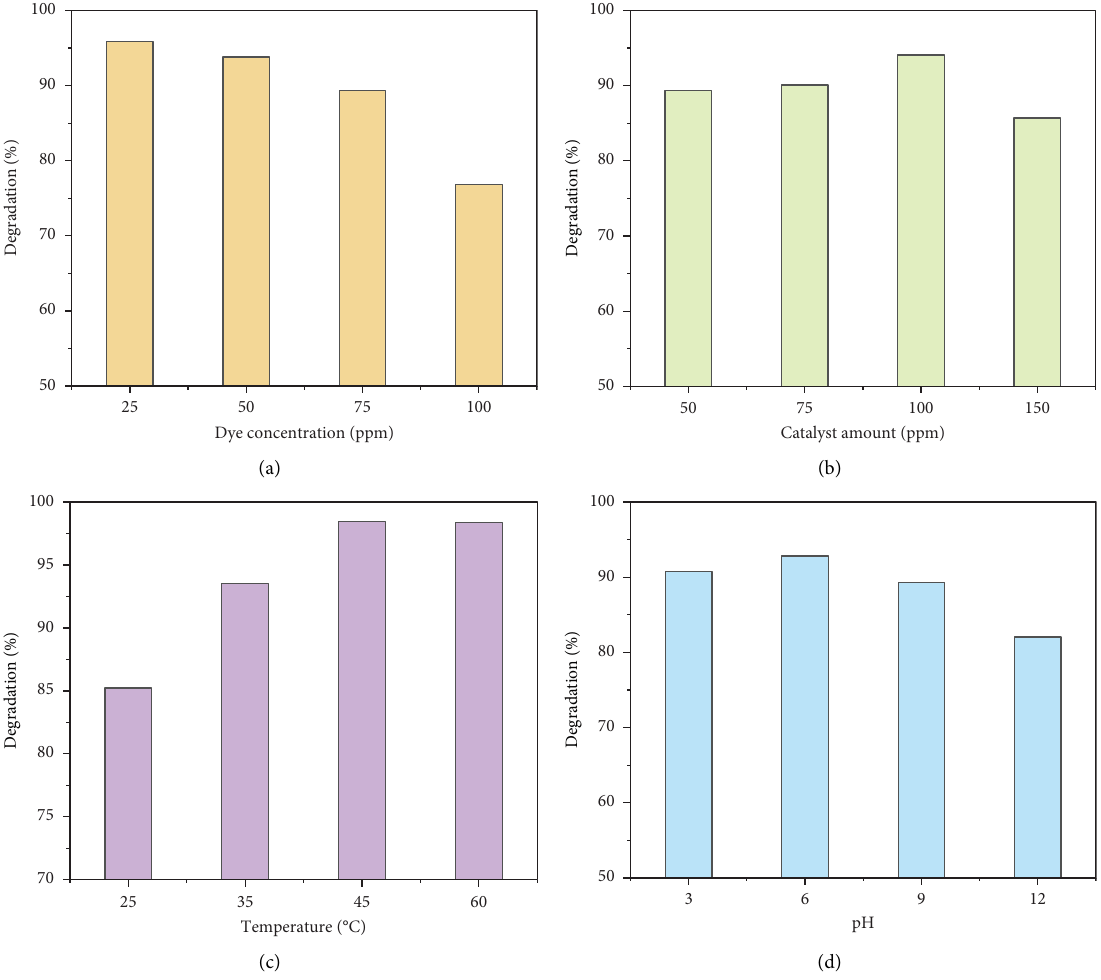
Figure 7: (a) Efect of dye concentration, (b) efect of catalyst dosage, (c) efect of temperature, and (d) efect of pH on eosin yellowish removable after 15min exposure